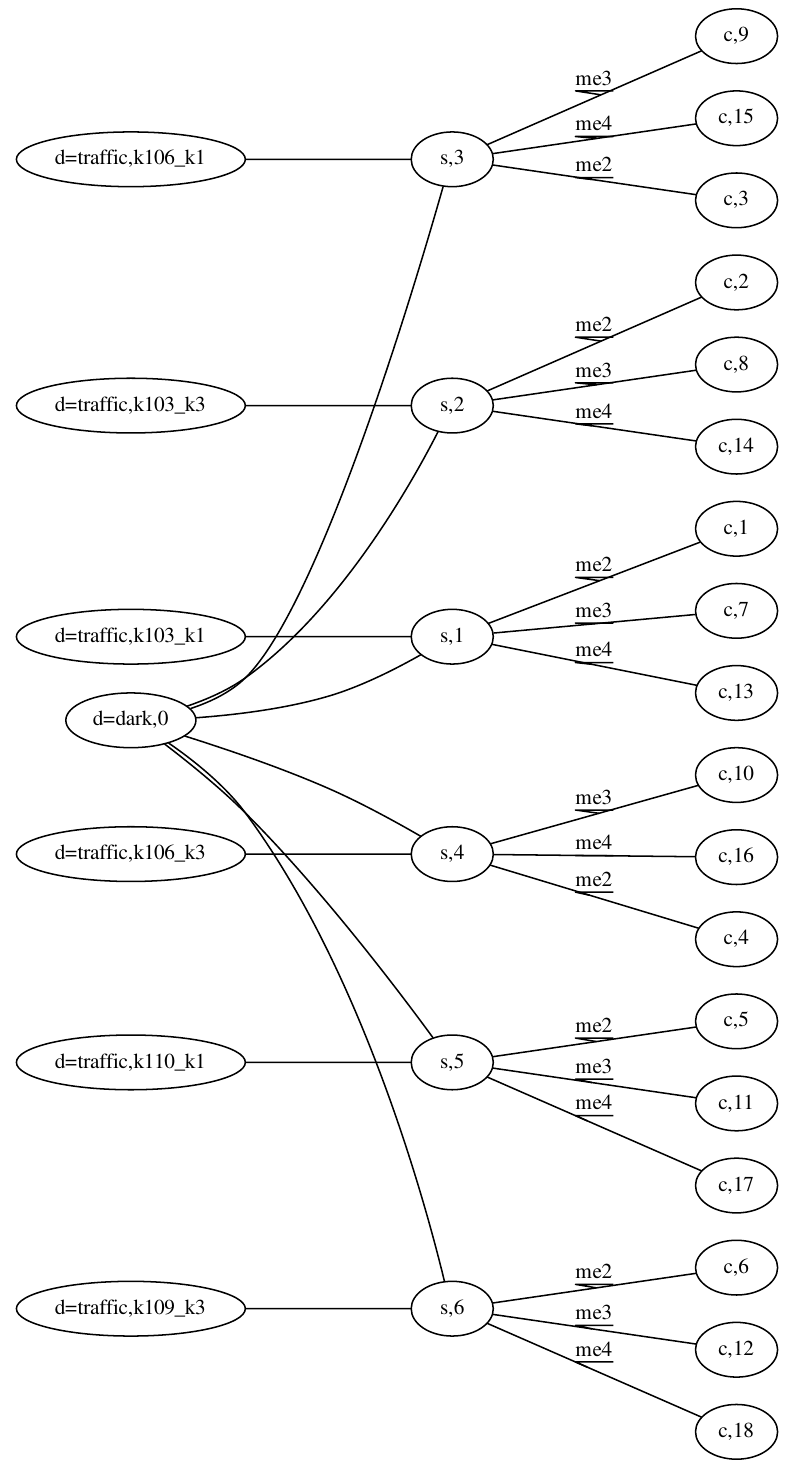
Figure 3. The control availability graph for the considered